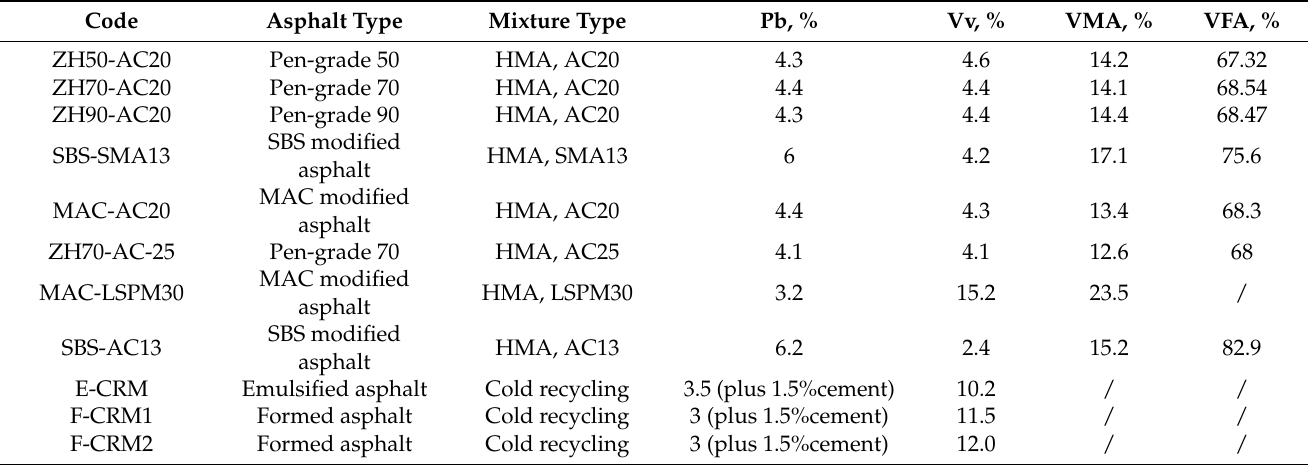
Table 4. Material types and volume indices of several asphalt